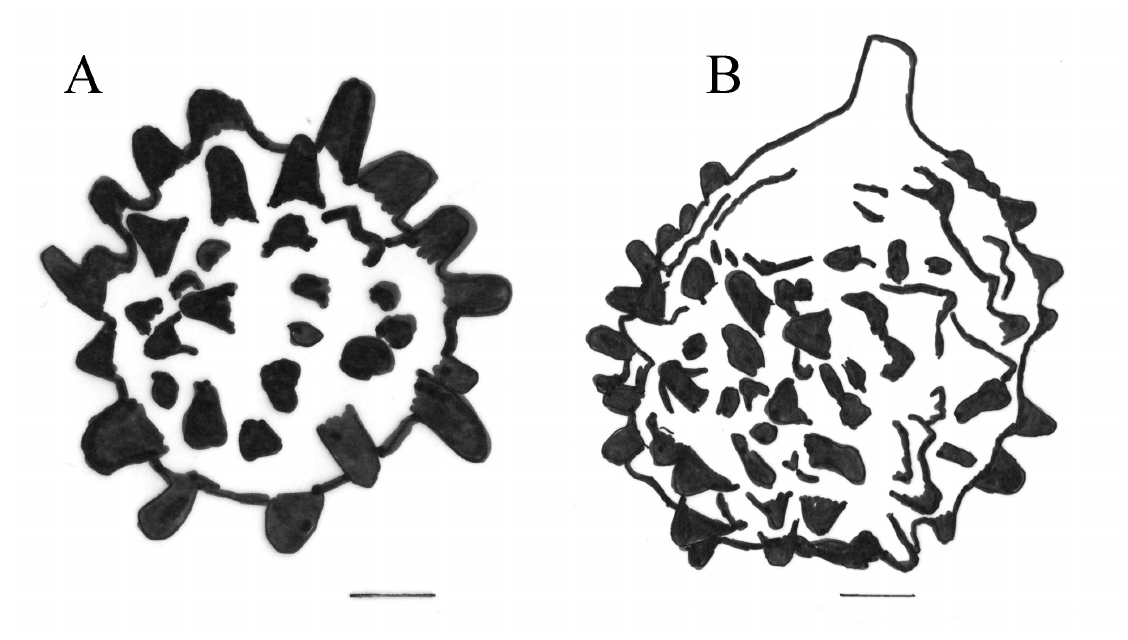
Fig. 7. Line drawings of basidiospores. A . Russula coronaspora Y.Song sp. nov. (GDGM79711) B . R. minor Y.Song sp. nov., holotype (GDGM79686). Scale bars = 1 μm. Drawing by Yu Song.